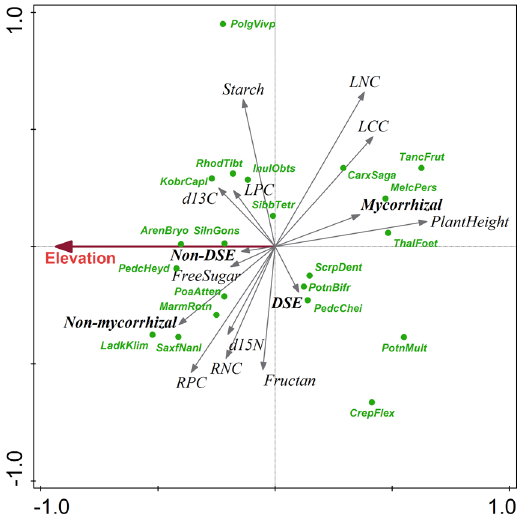
Figure 6. Analysis of plant functional traits. The first two partial RDA axes (after accounting for phylogenetic relations among species) showing the relationship between plant functional traits (ecophysiological parameters, AMF and DSE colonization) and elevation. Displayed axes explain 9.5% of the variance left after accounting for phylogenetic relations. Small arrows point in the direction of increasing expected values of corresponding plant traits, the large arrow points in the direction of increasing expected value of elevation. The twenty best-fitted plant species are shown. First four letters from genus and species names of host plants are used in diagram, full names are in Table S1. Full names of ecophysiological parameters are in the Table 1